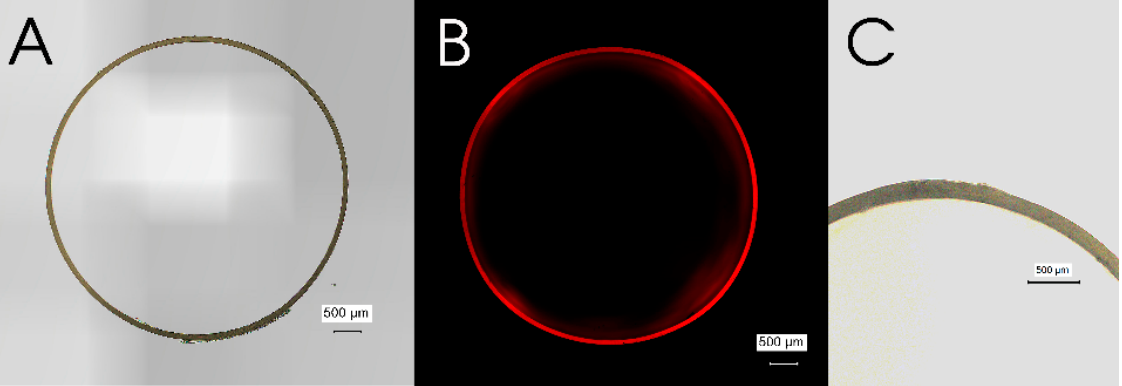
Figure 4. Cross-sectional images of an EA doped enteric-coated gelatin capsule. ( A ) a brightfield stitched image, ( B ) a fluorescent stitched image with a red excitation filter, and ( C ) a single brightfield image of the wall of a gelatin capsule. Scale bars indicate 500 µ m.